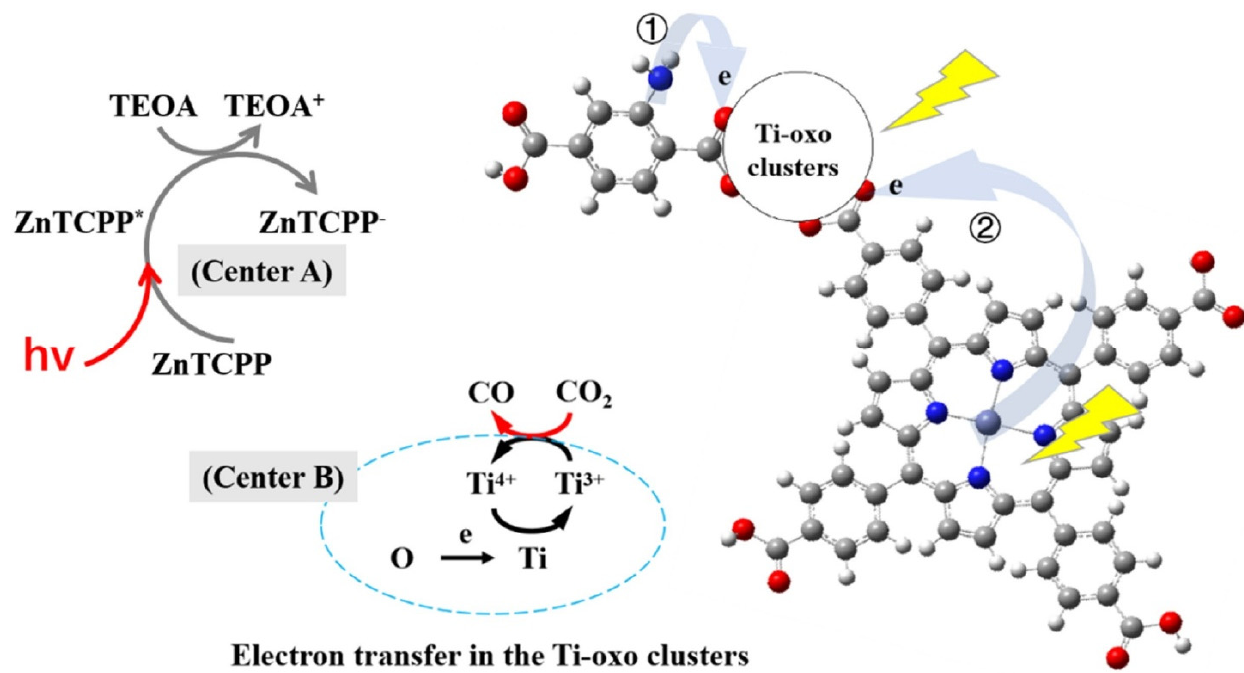
Figure 4. The reaction mechanism of photocatalytic CO 2 reduction using D-TiMOF. Reprinted with permission from Ref. [131]. Copyright 2022 Elsevier.